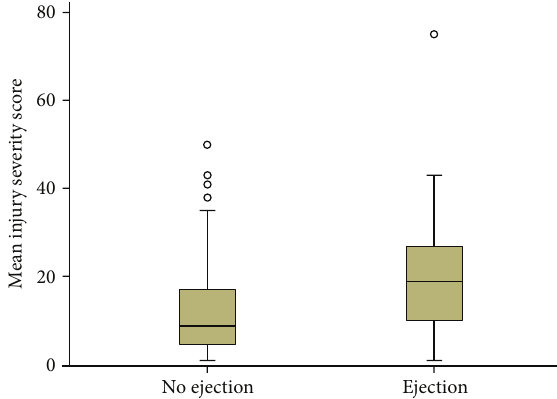
Figure 1: Side-to-side boxplot for correlation of rollover with ejec- tion and injury severity